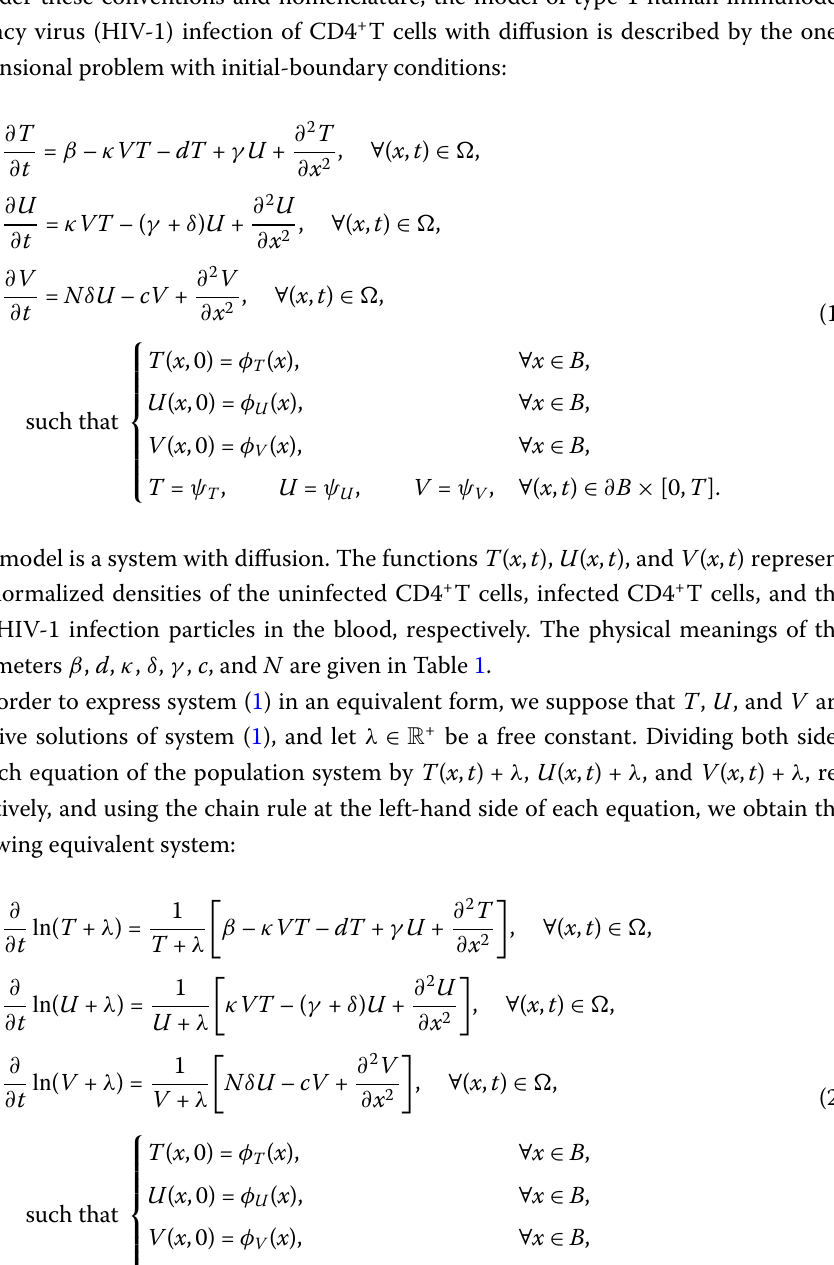
Average number of particles infected by infected